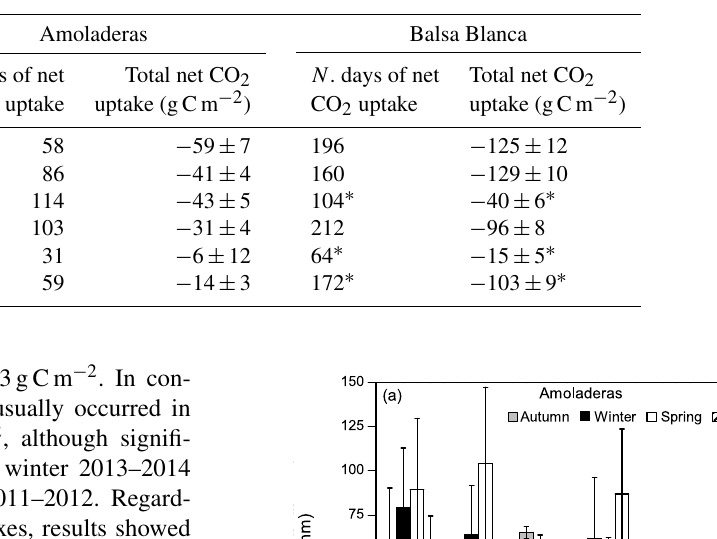
Table 4. Number of days with daily net CO 2 uptake and the related total C absorbed for every hydrological year and every field site of the study. Asterisks denote those years with abundant data losses ( ∼ 30% data).